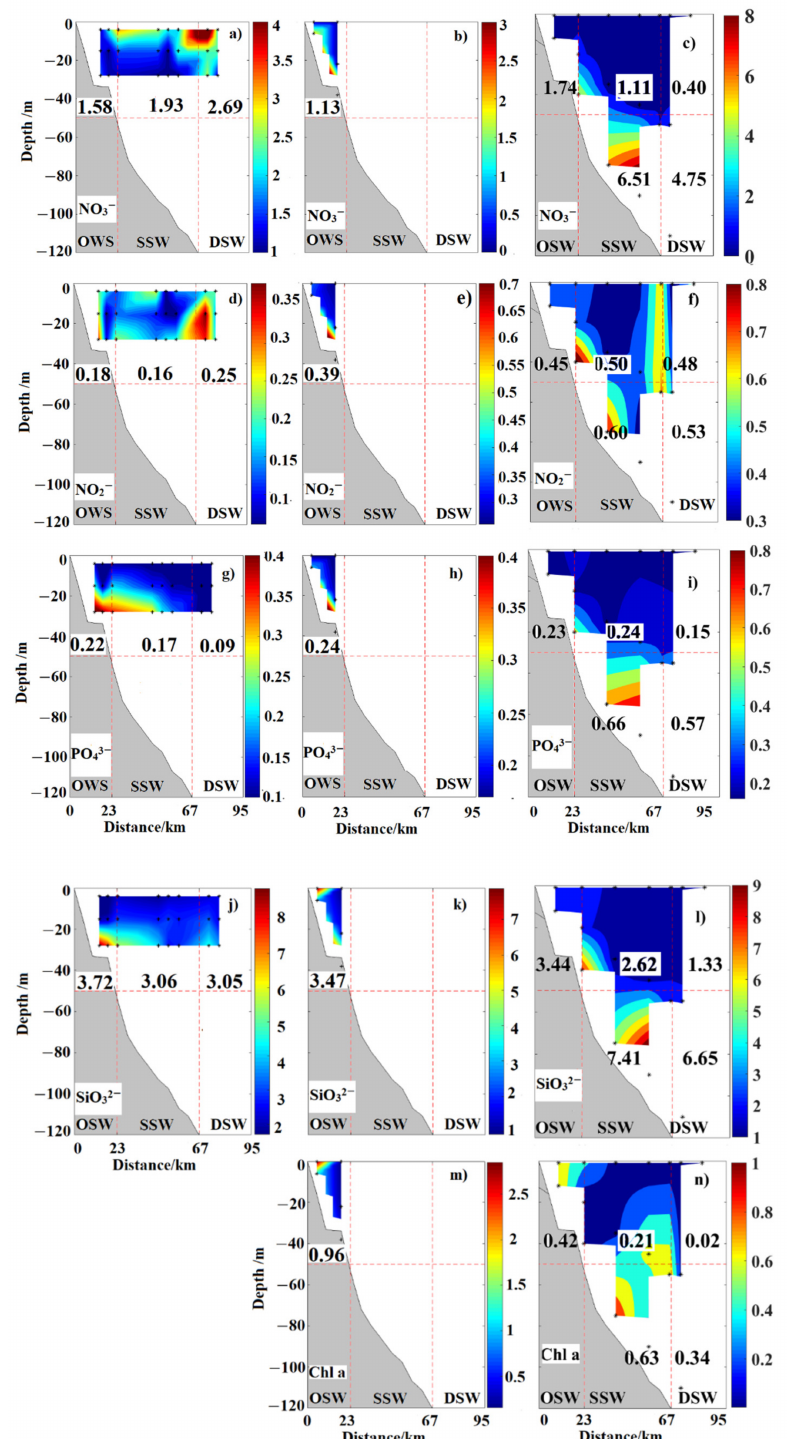
Figure 7. 2D ( x – z ) distributions of nutrient and Chl a concentrations. ( a , d , g , j ) Without the typhoon (Stations H3–H5, H9–H11, and H14–H15). ( b , e , h , k , m ) Before the typhoon (Stations H1–H4). ( c , f , i , l , n ) After the typhoon (Stations H1, H4, H8, H10, H12–H13, and H15–H16). Dotted red lines represent the positions of 50 m and 150 m isobaths and a depth of 50 m. Black stars represent stations and depths of the observations. Numbers represent the average